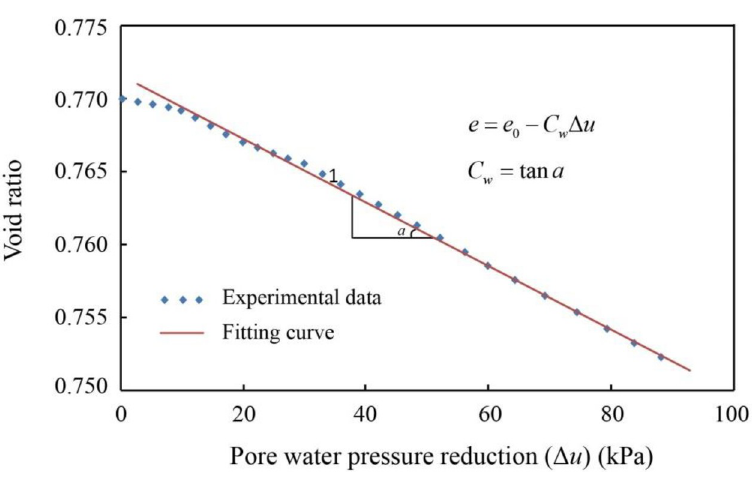
Fig 10. Linear subsidence model showing the variation in void ratio with pore water pressure